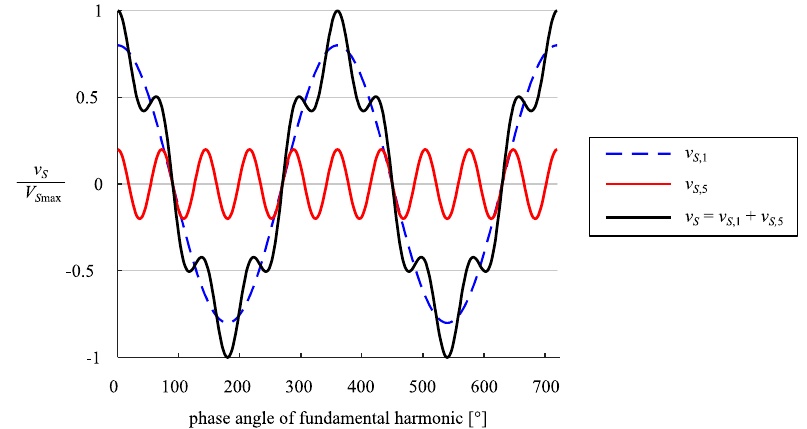
Figure 2. Converter voltage v S consisting of the first and fifth harmonic with phase displacement, leading to saturation (worst case scenario).